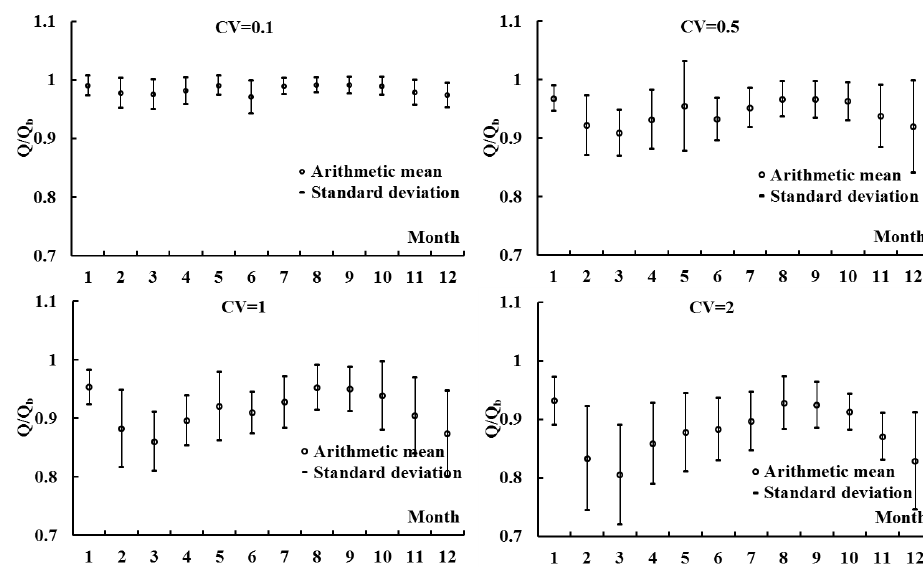
Figure 5. Means and confidence intervals of aquifer–stream discharge from local model.